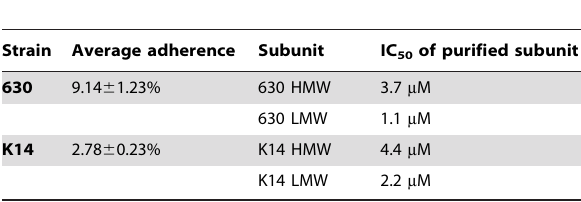
Table 5. Purified SlpA subunits inhibit adherence of vegetative C. difficile